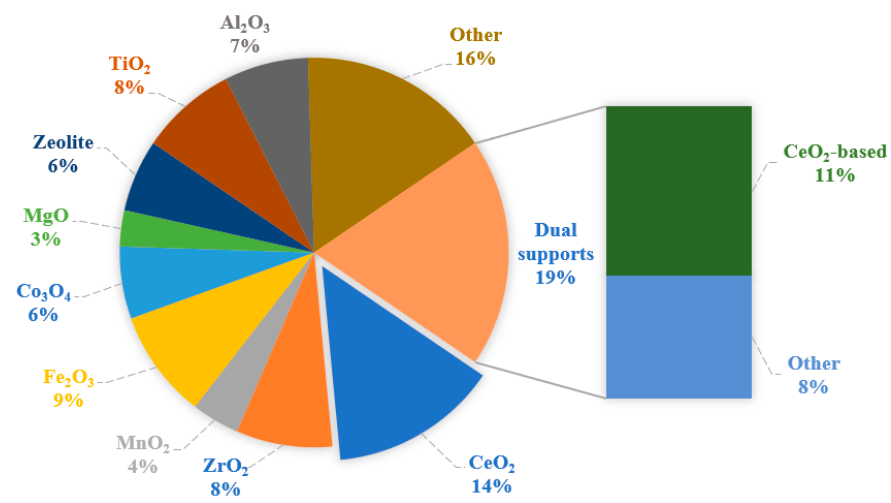
Figure 1. Supports used in CO removal from syngas streams using CO-PROX, WGSR or CO-SMET reactions.